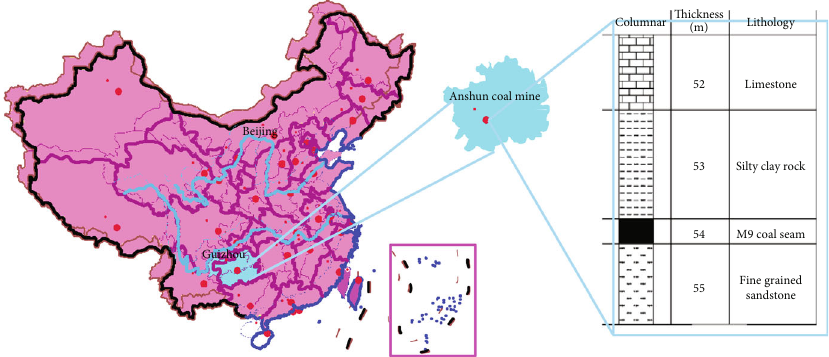
Figure 1: Geographical location of the experimental coal seam and the geographic conditions of the coal seam.